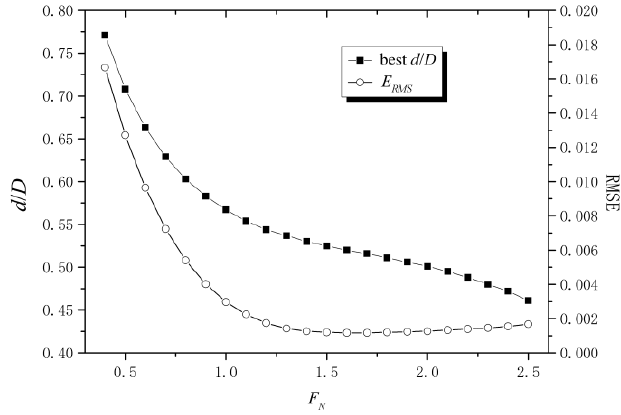
Figure 2. Best d / D in different F N and the corresponding E RMS .